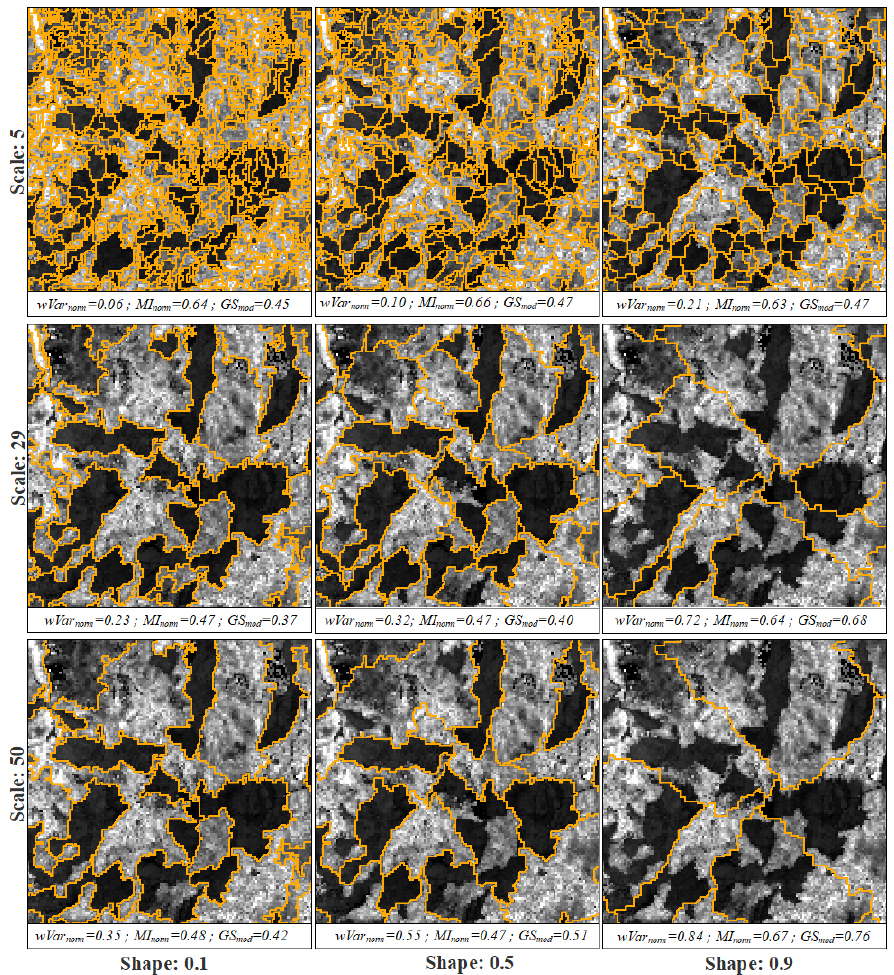
Figure 6. Segmentations of the ‘H95′ LiDAR metric generated by the multiresolution segmentation (MRS) algorithm with different combinations of the scale and shape parameters, and the same compactness parameter (Comp. = 0.1). In all cases, the segmentation is displayed as orange vectors overlaid on the ‘H95′ metric raster, shown in grayscale. The same 4 × 4 km area of Figure 1 is presented.